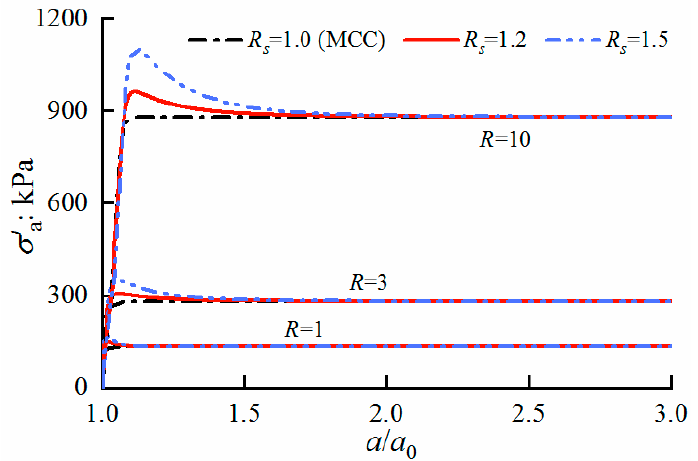
Figure 10. Relationship between the effective internal cavity pressure σ ′ a and the cavity radius a / a 0